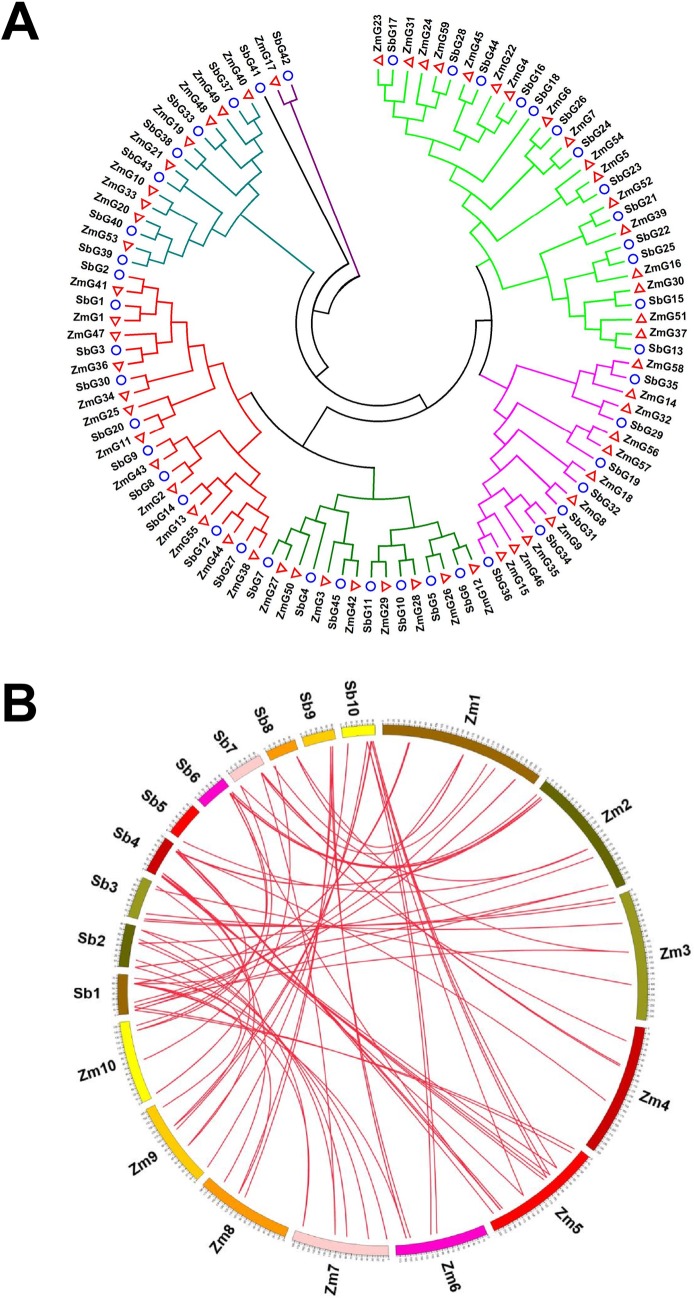
Phylogenetic analysis and duplication events of G2-like proteins between maize and sorghum.(A) Phylogenetic tree of ZmGs and SbGs. The tree was constructed using neighbor-joining method with MEGA 6.0. Maize G2-like proteins were presented by hollow red triangle, and sorghum G2-like proteins were presented hollow blue circular. (B) Synteny of maize and sorghum G2-like genes regions. Numbers along each chromosome box indicate sequence lengths in megabases. Maize and sorghum chromosome were presented by Zm1-Zm10 and Sb1-Sb10, respectively. All the syntenic genes across maize and sorghum were linked by red lines.